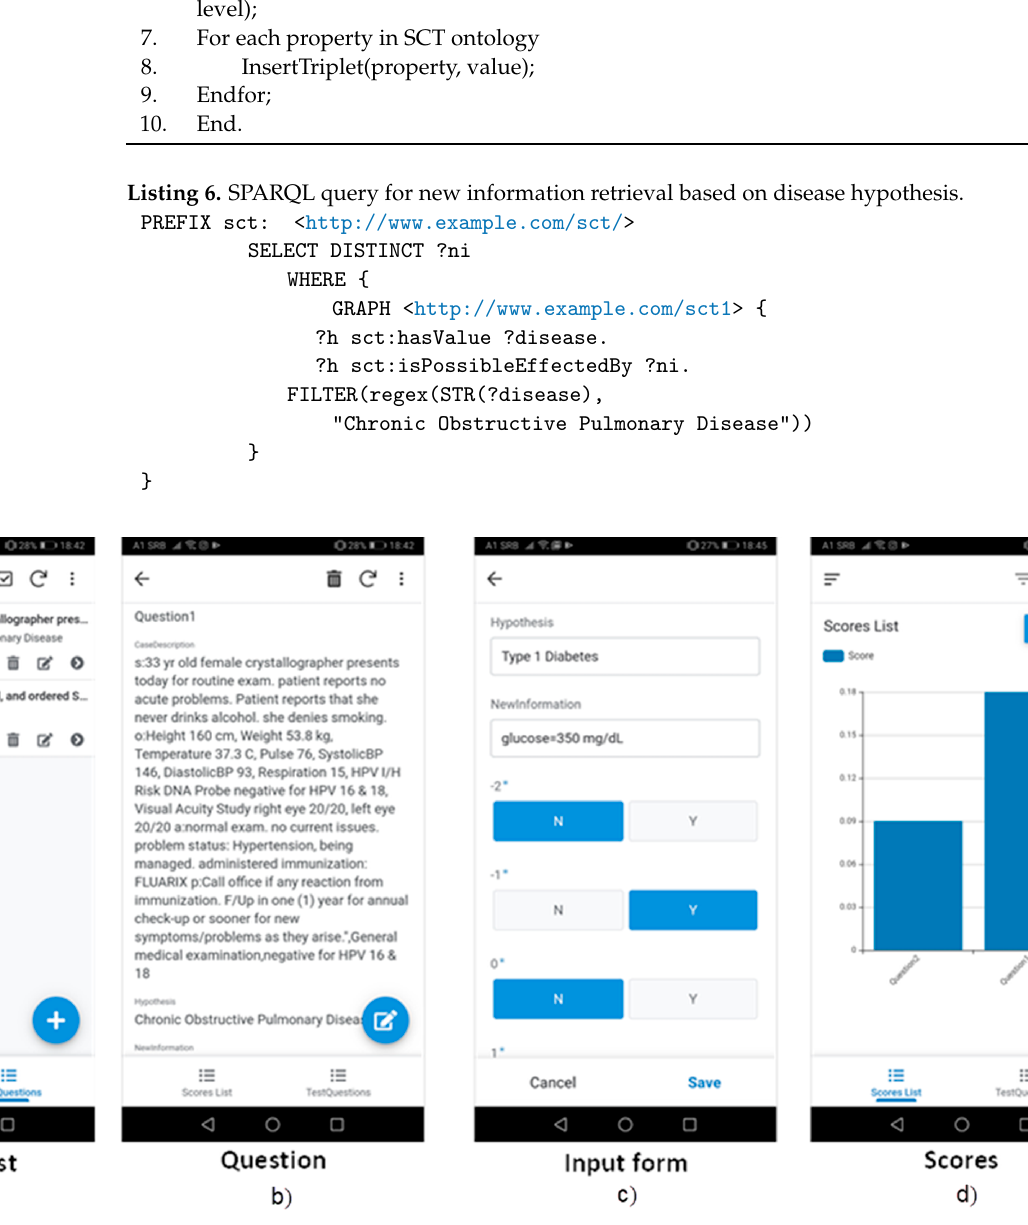
Figure 4. AppSheet-based SCT mobile app for students.